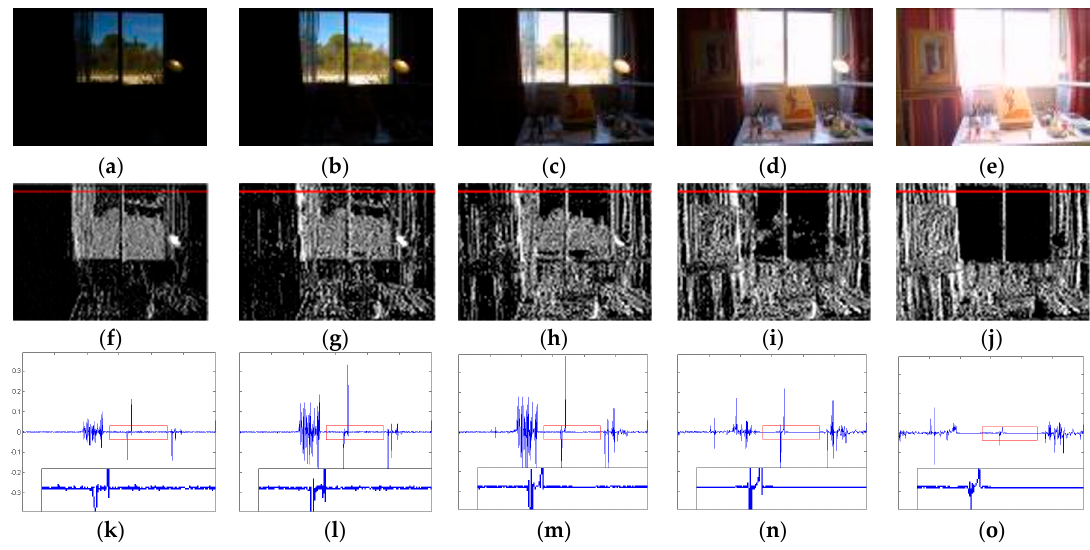
Figure 2. Local luminance gradient comparison of multi-exposure source images: ( a – e ) multi-exposure source images; ( f – j ) luminance gradient maps; and ( k – o ) luminance gradient amplitude of the red lines in ( f – j ).